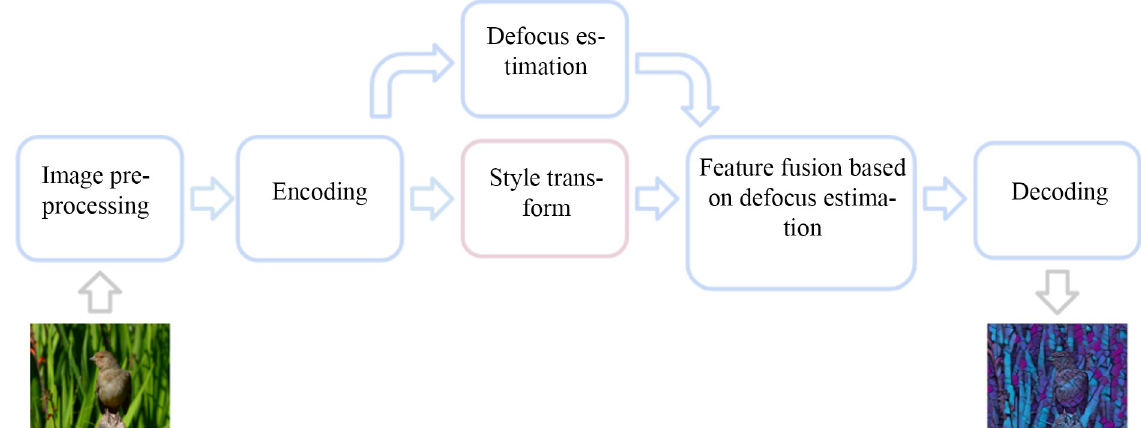
Fig 2. Workflow of the improved defocus adaptive style migration method based on the stroke pyramid.